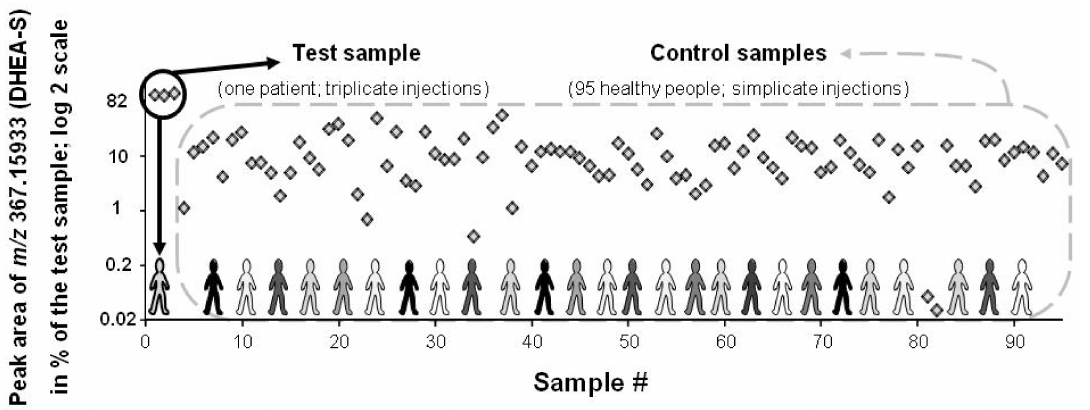
Figure 5. Peak area of a spiked feature (DHEA-S: [endogen.] + 20 µ M; m / z measured at 367.15933) in the test and control serum samples (black circle and dashed grey line box, respectively). Results are expressed as [% of the test sample] with a log 2 scale. In serum, DHEA-S population value ranges from 0.4 to 12 µ M (population diversity exemplified with various shades of grey). DHEA-S is ranked at the 1st and 25th position when, respectively, peak area or SD# are taken into